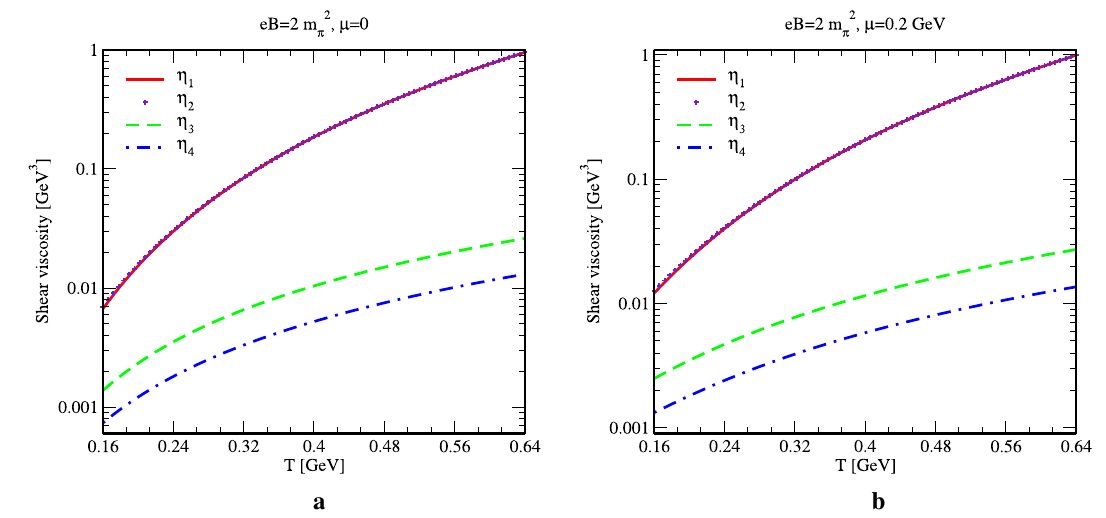
Fig. 3 Variations of the four shear viscosity coefficients with temperature ( a ) in the presence of weak magnetic field and ( b ) in the presence of finite chemical